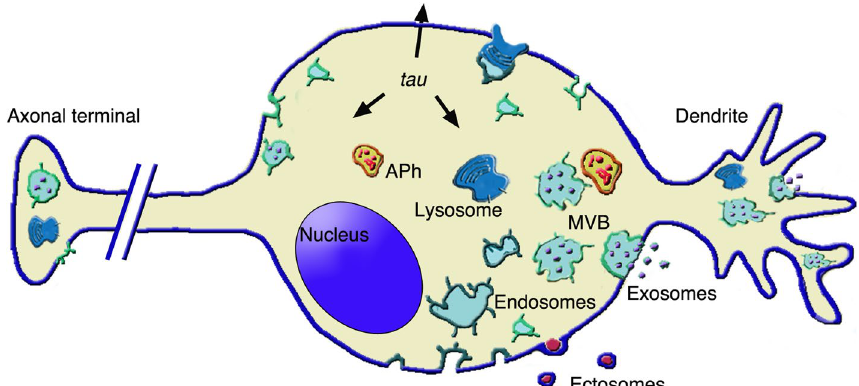
Fig. 2 Neuron: intense circulation of MVBs and other organelles involved in UPS processes. The continuous uptake of endosome vesicles (cerulean color) leads to various cisternae, with some (MVBs) accumulating large numbers of vesicles (violet). MVBs circulate inside the cell, distributed not only in the cytoplasm but also in dendrites (right) and axon terminals (left). Exocytosis of MVBs (right) results in the extracellular discharge of exosomes. The Figure illustrates also other organelles with role in UPS. Lysosomes (dark blue), in addition to their well-known digestive functions, become competent for exocytosis (top) upon fusion with endosomes. Autophagosomes (APhs, chamois yellow color with candy segregated structures) also circulate in the cytoplasm. They interact with MVBs and then undergo parallel exocytoses. Ectosomes (bottom, amethyst) are released by budding and fission of plasma membrane microdomains. Finally the Figure illustrates the state in neurons of protein tau (three small arrows), secreted by various, fluid and solid UPS processes [62–66]